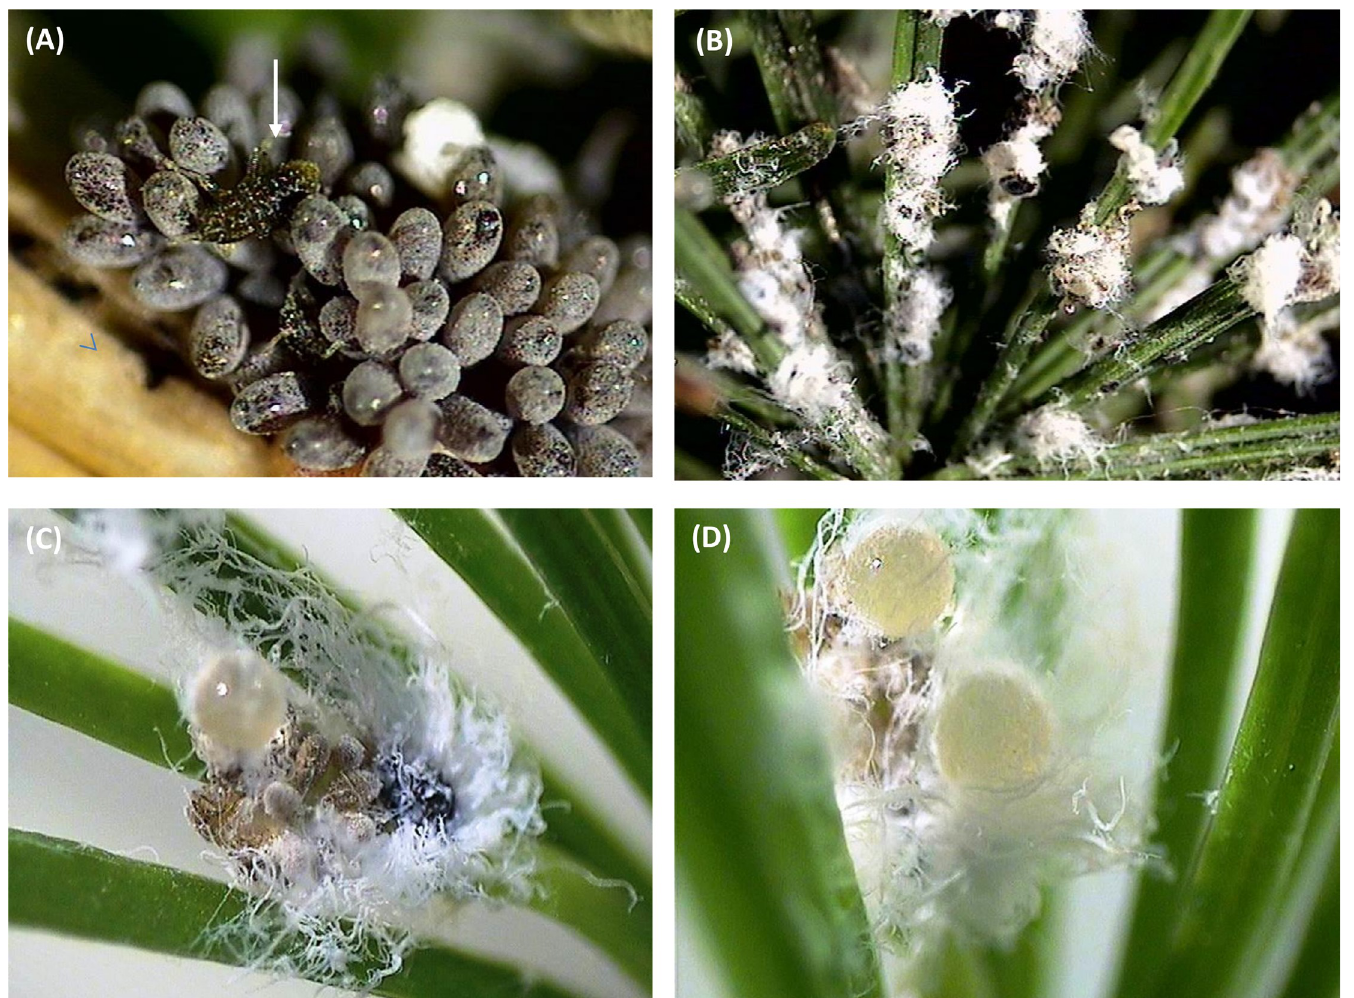
Fig 1. Parthenogenetic morphs of Adelges laricis exules on Larix decidua . (A) ‘Crawler’– 1 st instar nymph after hatching. The arrow points to the crawler. (B) ‘Wooly’ nymphs and females. (C-D) Wax-covered ‘spheres’ of accumulated honeydew. The ‘sphere’ is covered with wax and it often adheres to the insect and the egg clusters. Olympus DP-Soft binocular (10 x 6.3), Sony camera − Exwave HAD (1600 x 1200).